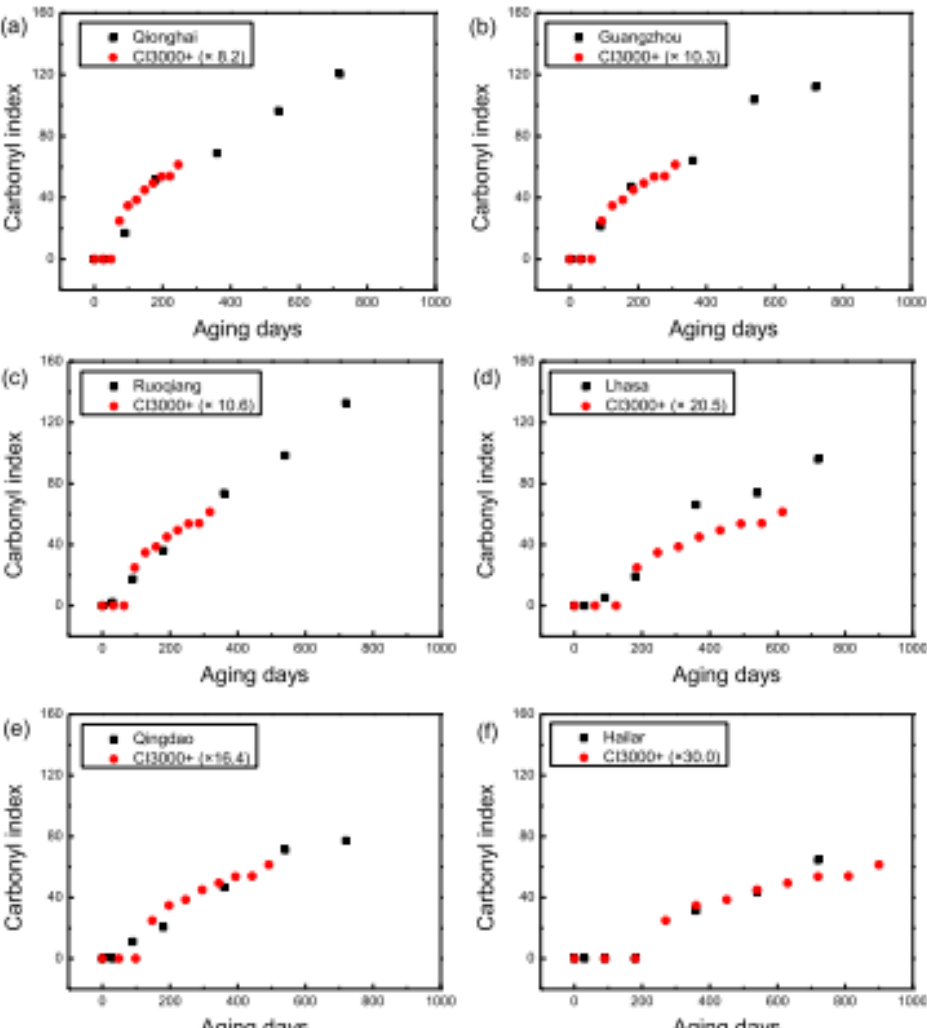
Figure 4. Comparison between results from outdoor exposure, performed in six different locations in China (( a ): Qionghai; ( b ): Guangzhou; ( c ): Ruoqiang; ( d ): Lhasa; ( e ): Qingdao; ( f ): Hailar), and predictions from accelerated aging, based on carbonyl index. Reprinted with permission [31].